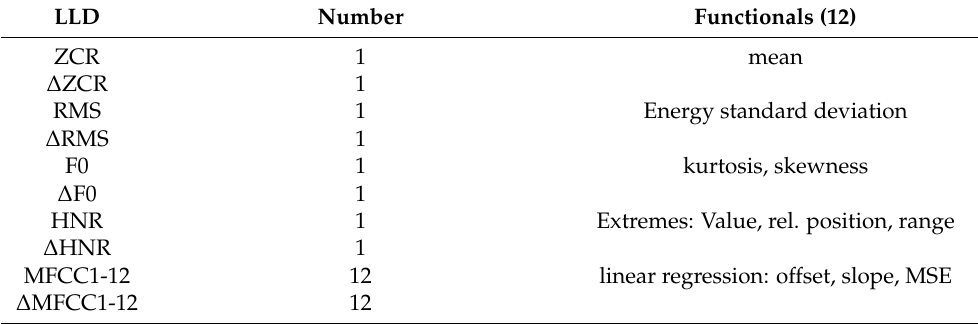
Table 4. Features in INTERSPEECH 2009 Emotion Challenge.